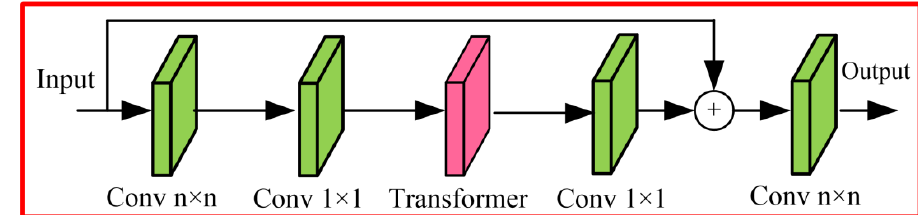
Figure 5. MobileDViT block.